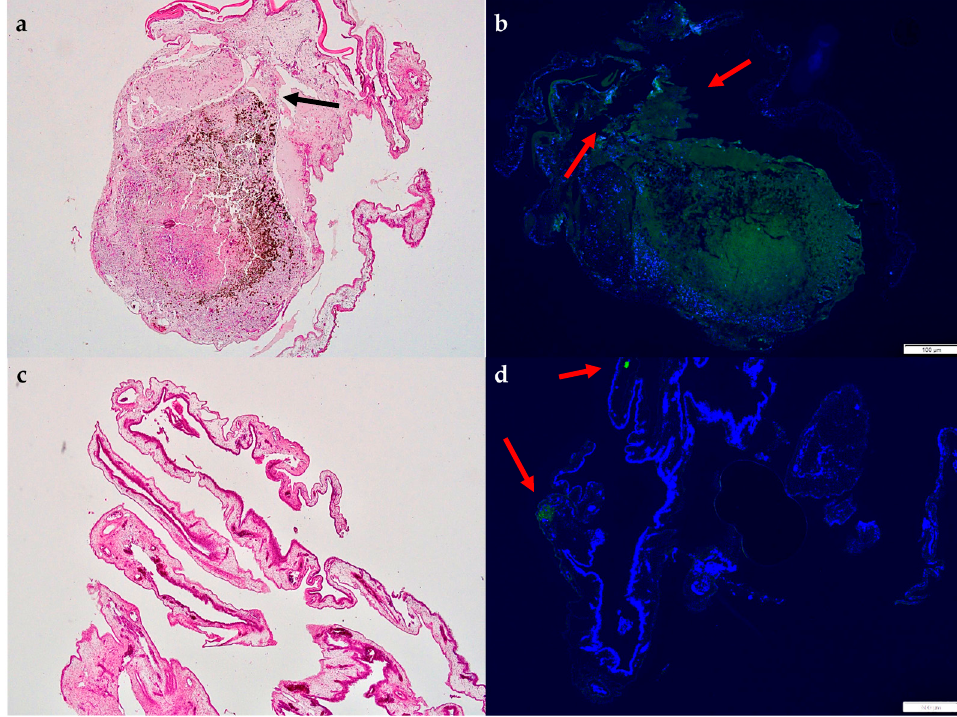
Figure 12. Images of H&E staining and fluorescence microscopy of an excised patient-derived UM-xenograft, as well as of the lower CAM. ( a ) Hematoxylin and Eosin staining of the tumor nodule implanted with Matrigel with a depiction of the folding of the CAM around the tumor graft, as well as the dispersion and invasion of the pigmented cells in depth under the tumor base (arrow), ( b ) fluorescent microscopy after the application of melanoma-specific staining (green) for the identification of uveal melanoma cells (arrows), scale 100 µm, ( c ) hematoxylin and eosin staining of the lower CAM, ( d ) fluorescent microscopy of the lower CAM with weakly visible signaling of melanoma cells (arrow), scale 100 µm.